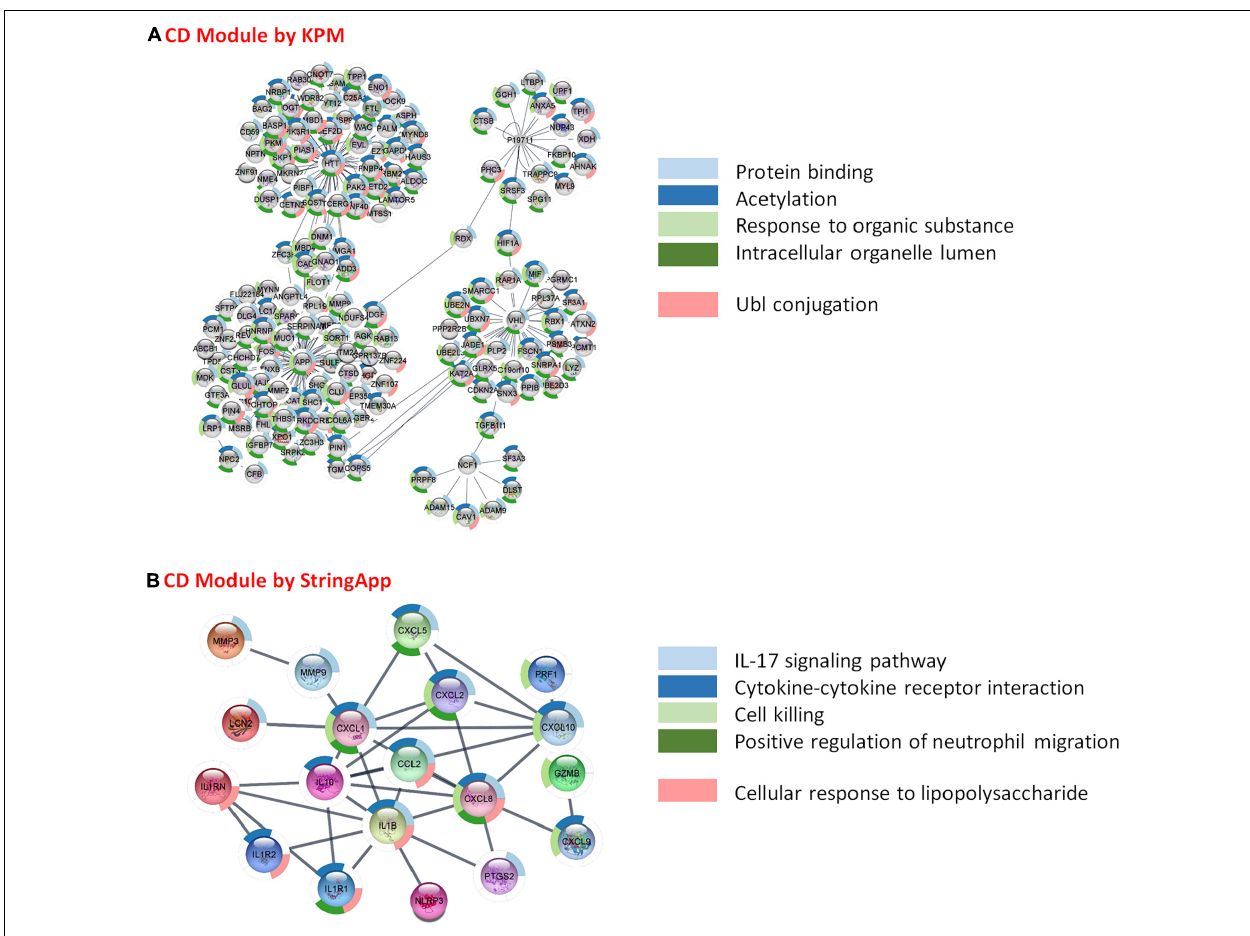
FIGURE 8 | Functional analysis and comparison of CD-specific modules. (A) CD-specific module by KeyPathwayMiner (KPM) and the top 5 enrichment results based on the p-value. (B) CD-specific module by StringApp and the top 5 enrichment results based on the